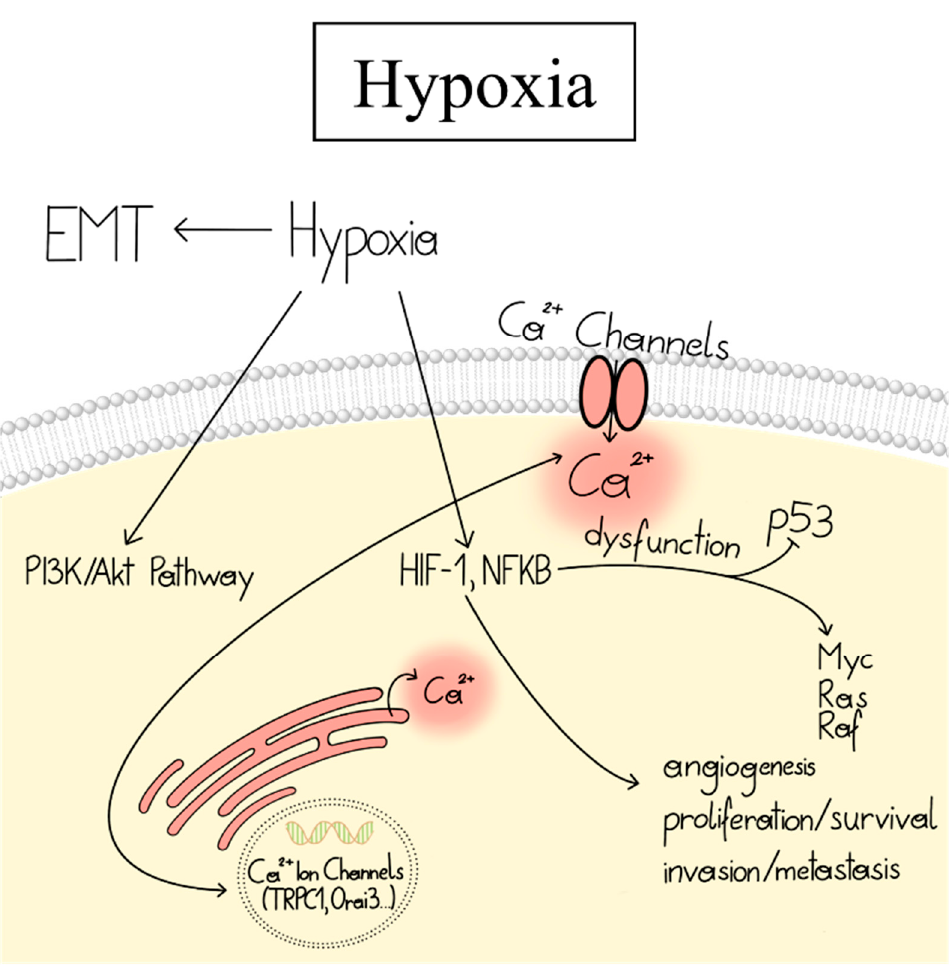
Figure 2. Linkage of hypoxia and the Ca 2+ -signaling machinery in cancer. Hypoxia induces EMT and activates PI3K/Akt, HIF, and NFkB signaling pathways. HIF-1 is involved in angiogenesis, cell proliferation/survival, and invasion/metastasis. It can trigger upregulated expression of Ca 2+ ion channels, leading to enhanced Ca 2+ levels that promote transcription of oncogenes. Conversely, Ca 2+ can modulate HIF-1 signaling. Software used for all figure drawings: Procreate, Chemdraw (RRID:SCR_016768).